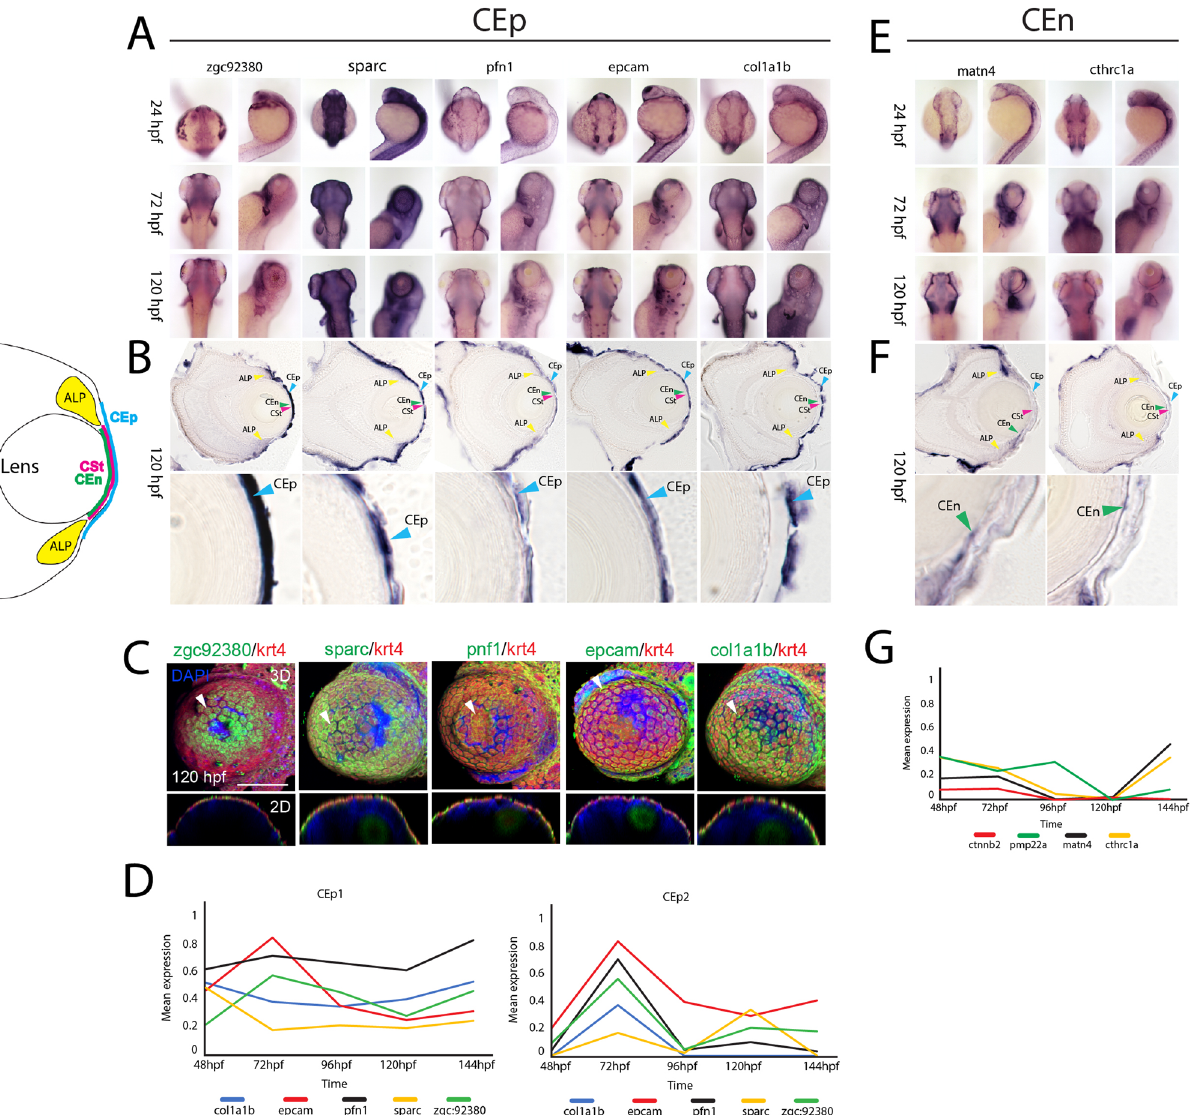
Figure 7. Spatiotemporal expression patterns of conserved corneal epithelium and endothelium associated genes. ( A ) WISH analysis of corneal epithelium associated genes zgc:92,380, sparc, pfn1, epcam and col1a1b expression at 24, 72 and 120 hpf displayed in dorsal and lateral views. ( B ) 10 µm cryosections of 120 hpf embryo eyes after WISH. ( C ) Two color FWISH depicting co-expression of krt4 (red)/ zgc:92,380 (green), sparc(green)/ krt4 (red), pfn1 (green)/ krt4 (red), epcam (green)/ krt4 (red) and col1a1b (green)/ krt4 (red) at 120 hpf. DAPI (blue) was used to stain the nuclei. Volume projections in lateral view and single section dorsal views from 3D confocal stacks are displayed. White arrows indicate example regions of co-expression. Scale bar = 100 µm. Individual fluorescence channels are provided in Fig. S10. ( D ) Average mean expression measurements from CEp1 and CEp2 clusters for marker genes krt4, krt5, krt91 and icn2 as well as col1a1b, epcam, pfn1, sparc and zgc92380 at each timepoint examined, 48–144 hpf. ( E ) WISH analysis of corneal endothelium associated genes matn4 and cthrc1a expression at 24, 72 and 120 hpf displayed in dorsal and lateral views. ( F ) 10 µm cryosections of 120 hpf embryo eyes after WISH. ( G ) Average mean expression measurements from CEn clusters for pmp22a, ctnnb2, matn4 and cthrc1a at each timepoint examined, 48–144 hpf. ALP Annular ligament progenitor (yellow arrow), CEp Corneal epithelium (blue arrow), CEn Corneal endothelium (green arrow), CSt Corneal stroma (green